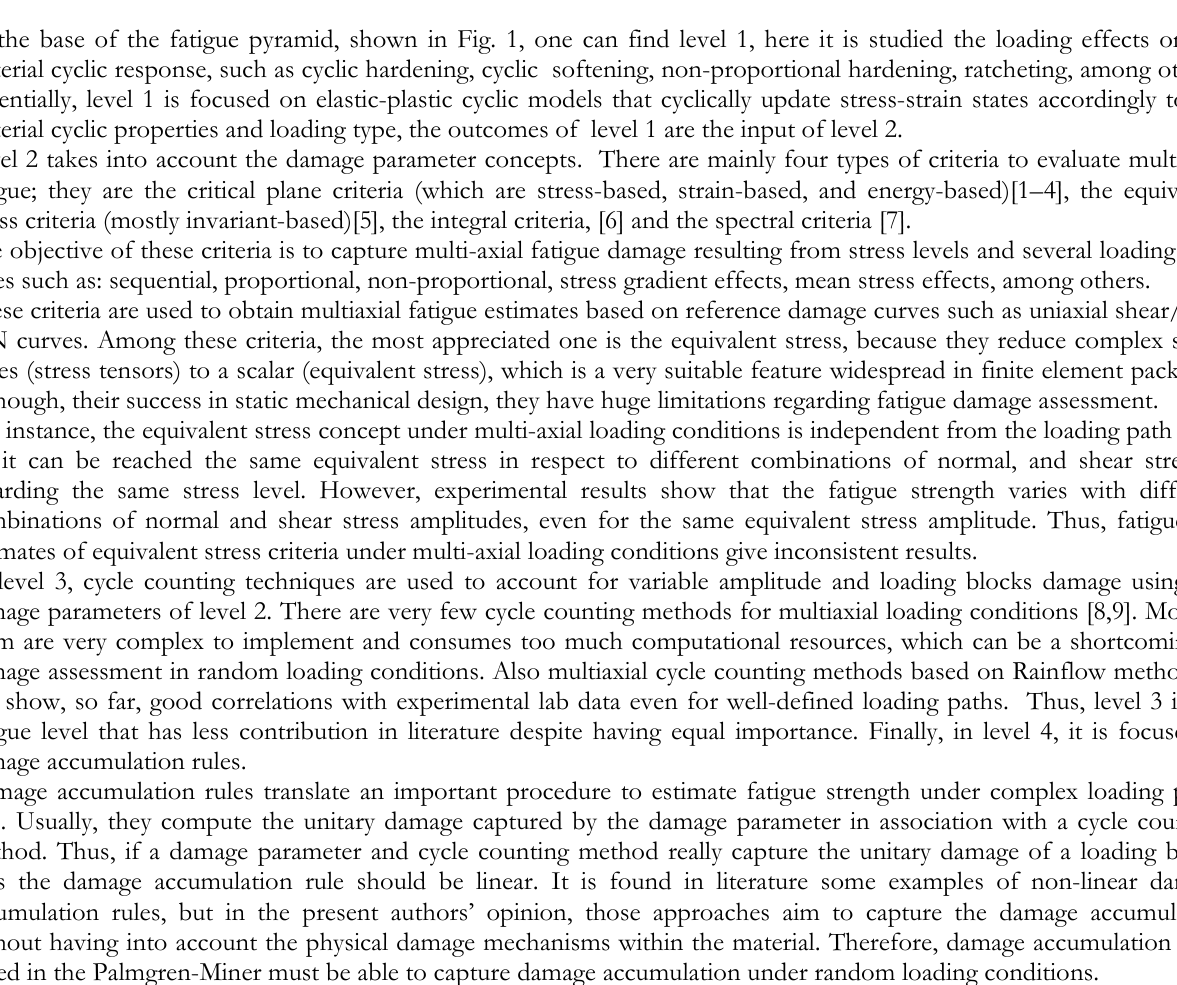
Figure 1: Fatigue levels of random fatigue